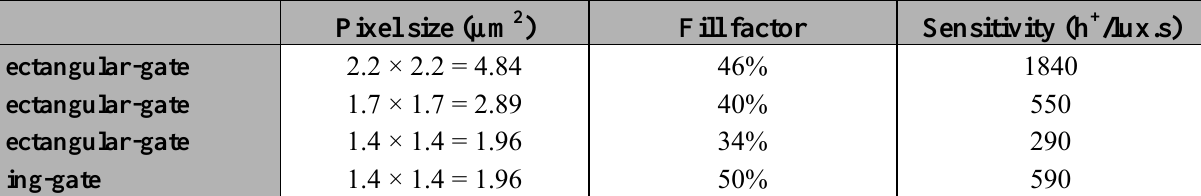
Table 4. Different design configurations and their sensitivity evaluated by measuring test